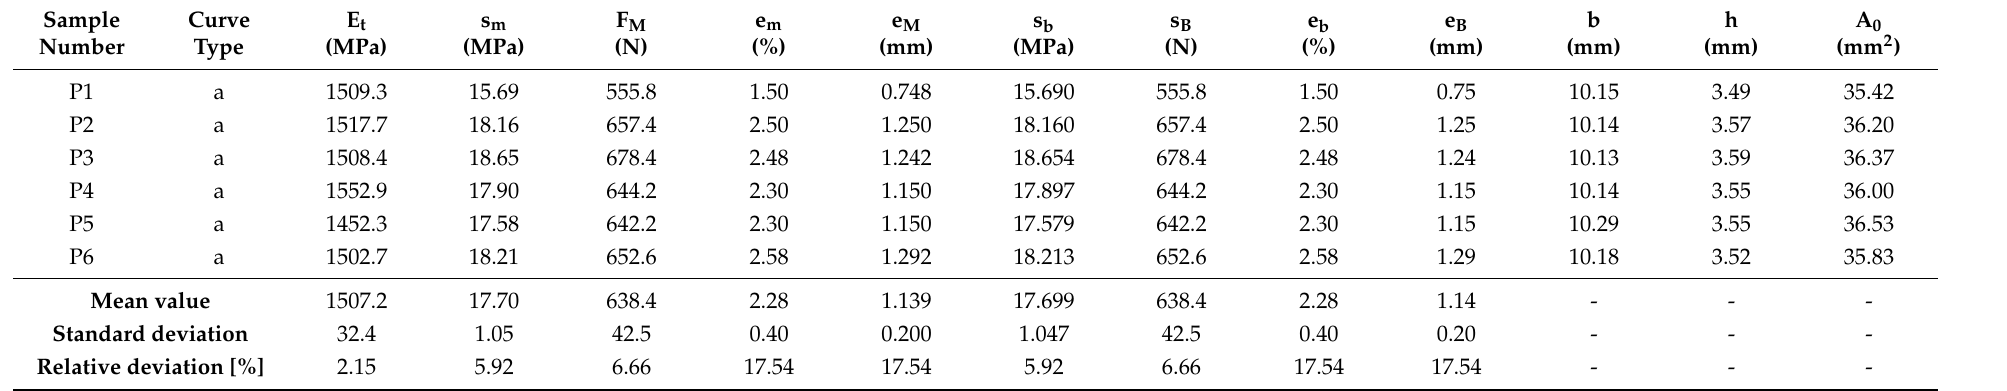
Table A31. Results of the tensile tests of